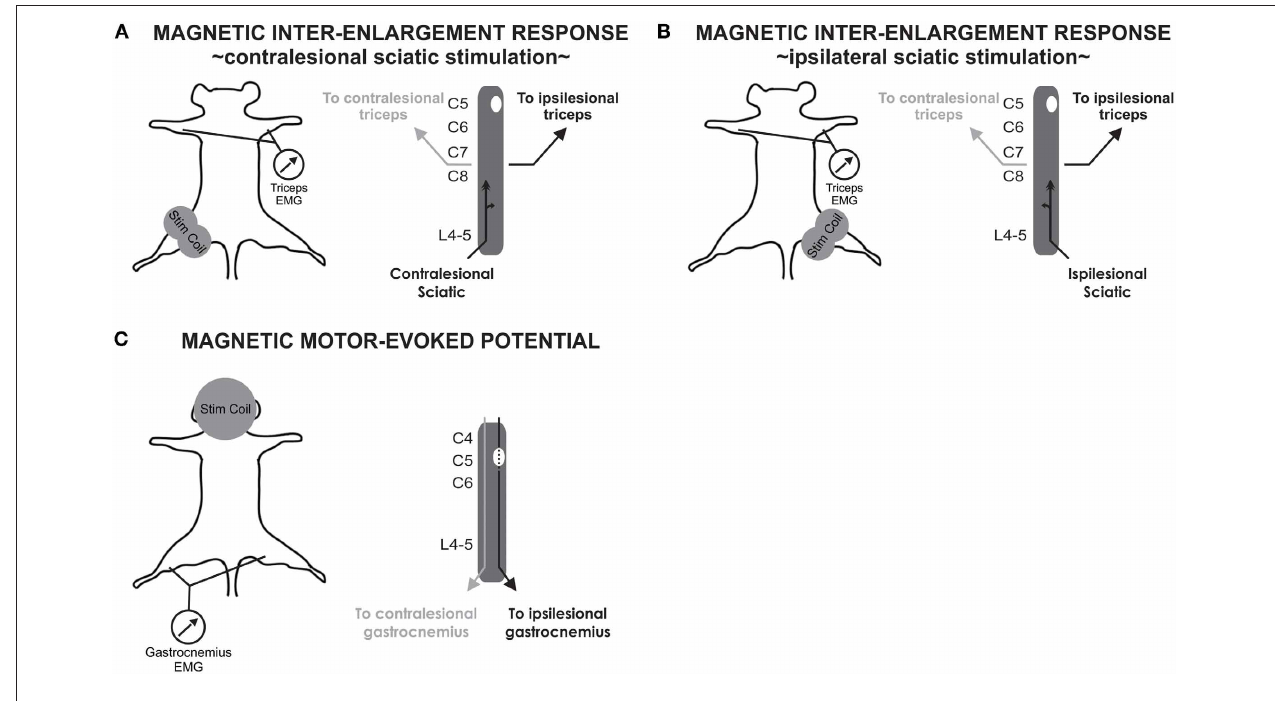
FIGURE 1 | Experimental procedure for stimulation and recordings of MIER and MMEP. (A) MIERs are evoked with a figure of eight coil positioned at the hip to stimulate the contralesional sciatic nerve. Recordings are performed in the triceps brachii bilaterally. (B) MIER